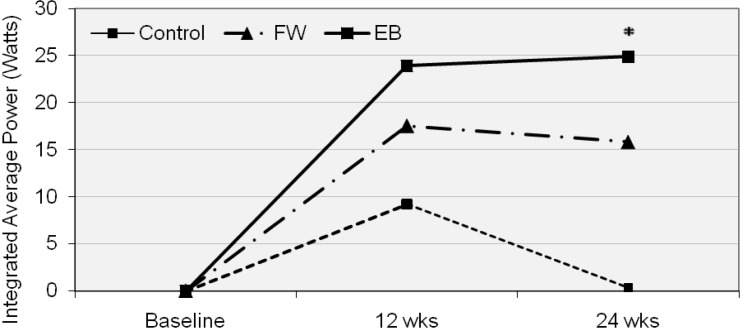
Values are presented as the integrated average power values encompassing all speeds at baseline, 12 and 24 weeks. * denotes statistically different from CON (p < 0.05). CON=control group; FW=free weight group; EB=elastic band and free weight combined training group